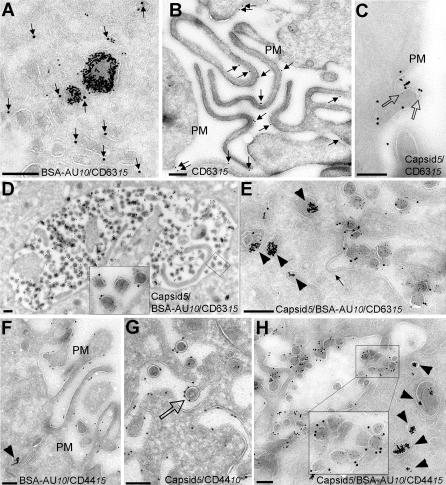
Localization of CD63 and CD44 in HIV-1-Infected MDMHIV-1 strain Ba-L-infected MDM were fed with 10 nm BSA-gold (except in G) for 2 h before fixing. Thawed cryo-sections were single-labeled with anti-CD63 (A and B, 15 nm gold) or anti-CD44 (F, 15 nm gold); or double-labeled with anti-capsid (C–E, G, and H, 5 nm gold) and anti-CD63 (C–E, 15 nm gold); or anti-CD44 (G, 10 nm gold and H, 15 nm gold).(A) CD63 (arrows) on endosomes efficiently filled with BSA-gold and on tubular vesicular membranes nearby.(B) CD63 (arrows) on plasma membrane protrusions of two adjacent cells.(C) A virus-budding profile labeled for anti-capsid (5 nm gold, open arrows) and anti-CD63 (15 nm gold) at the plasma membrane.(D and E) Virions inside vacuolar structures, labeled with anti-capsid (5 nm), are significantly labeled with anti-CD63. The inset in (D) shows the enlargement of double-labeled virions in the boxed area of (D). CD63 also localizes to BSA-gold-filled endosomes (arrowheads in E). Note that the virus-filled structure in (E) is devoid of 10 nm BSA-gold and displays a structure that resembles a clathrin-coated pit (small arrow).(F) CD44 at the plasma membrane.(G and H) CD44 on virions and on a budding profile (open arrow in G). The inset in (H) is an enlargement of the boxed area in (H) and shows several double-labeled virions inside a vacuolar structure.Note that CD44 is excluded from BSA-gold-filled endosomes (arrowheads in F and H). PM, plasma membrane. Bars, 200 nm.